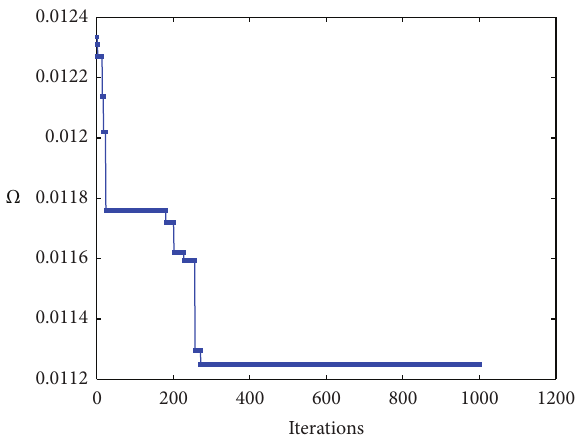
Figure 3: Fitting error evolution of the Ω operator for the car body example for 1000 iterations.